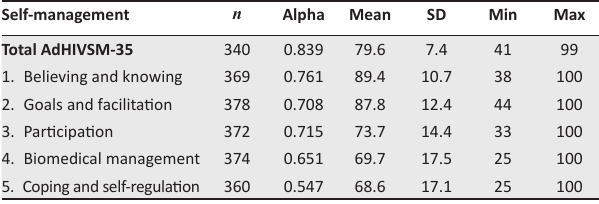
TABLE 6: Self-management sub-scale percentage